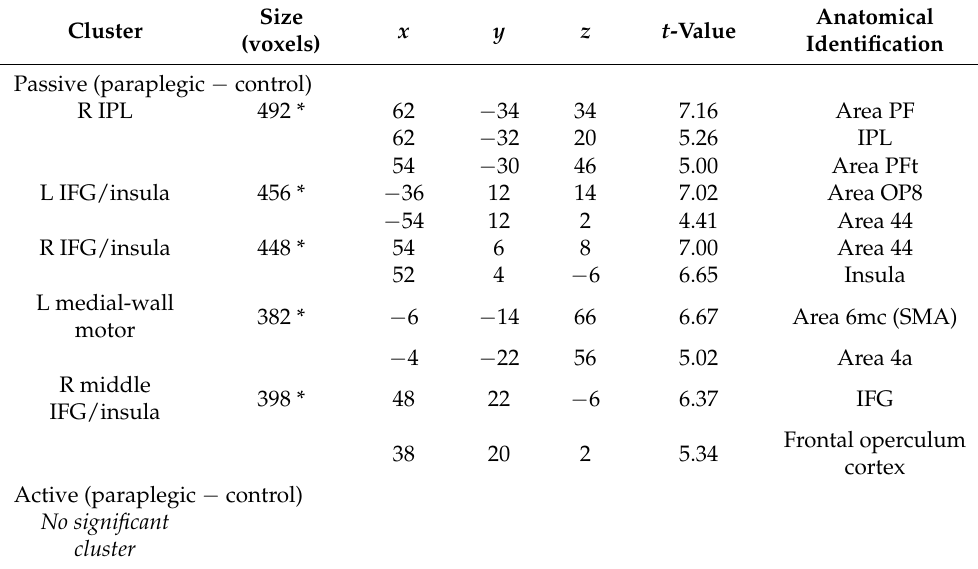
Table 2. Brain regions that showed significant group difference in each task identified in whole brain analysis. Cluster